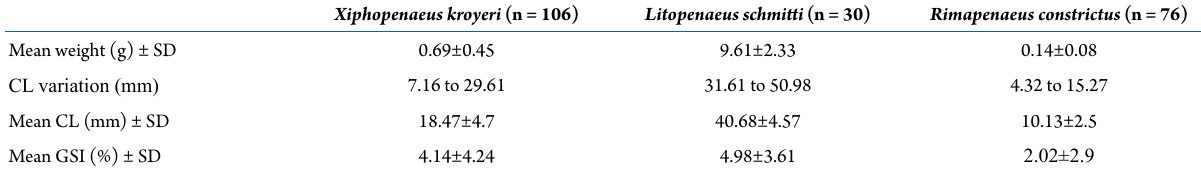
Table 2. Carapace length variation (mm) and mean values of weight, carapace length and gonadosomatic index for seabob shrimp ( Xiphopenaeus kroyeri ), white shrimp ( Litopenaeus schmitti ), and roughneck shrimp ( Rimapenaeus constrictus ) females from Ubatuba region, São Paulo, Brazil. (“n” = number of specimens analyzed)